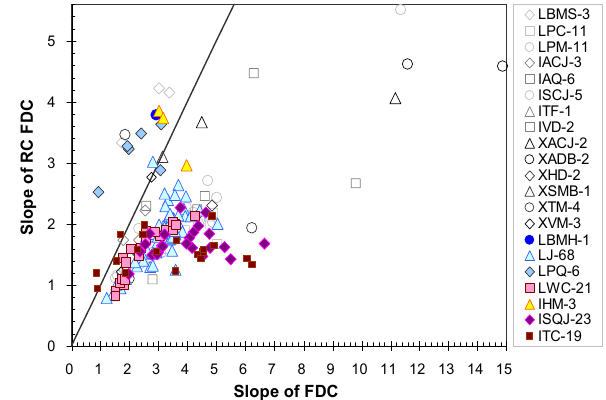
Fig. 12. Smoothed regime curve of total streamflow (top) and cor- responding flow duration curve (bottom), both at the daily scale and normalized by mean annual daily flow. (Legend description is given as US state abbrev., catchment class, dominant model process).